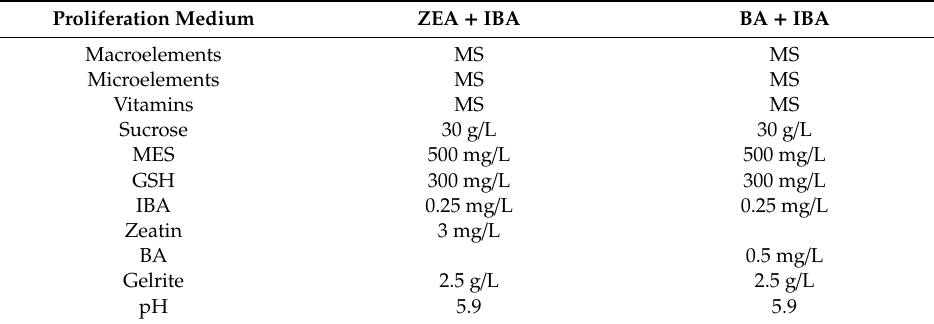
Table 2. Composition of media used for proliferation